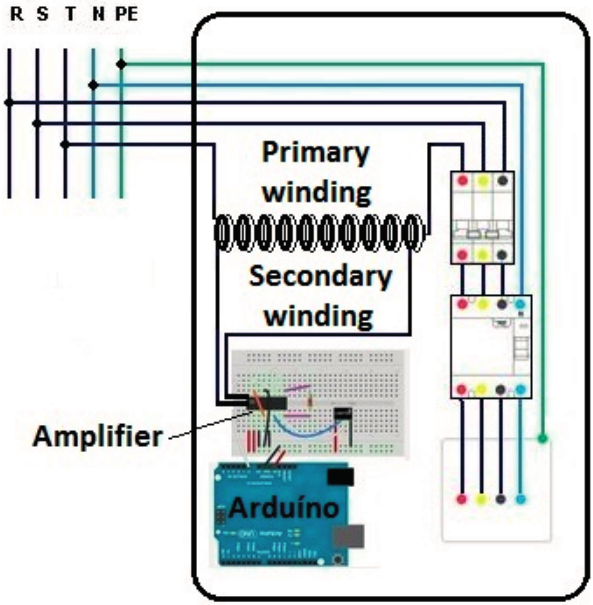
Figure 1. Proposed sensor installed within the switchboard of a